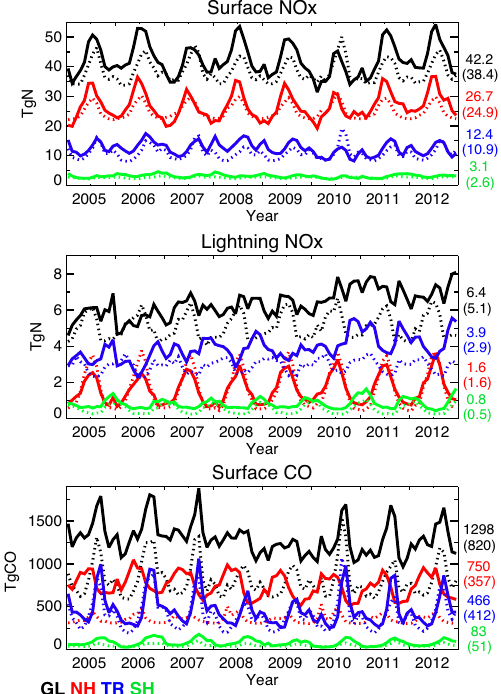
Figure 15. Time series of monthly total global and regional surface NO x emissions (in TgNyr − 1 , top), LNO x emissions (in TgNyr − 1 , centre), and surface CO emissions (in TgCOyr − 1 , bottom) ob- tained from the reanalysis (solid lines) and the emission inventories or the control run (dashed lines) over the globe (90 ◦ S–90 ◦ N), NH (20–90 ◦ N), tropics (TR, 20 ◦ S–20 ◦ N), and SH (90–20 ◦ S). The 8- year mean emissions values obtained from the reanalysis run and the emission inventories (in bracket) are shown on the right-hand